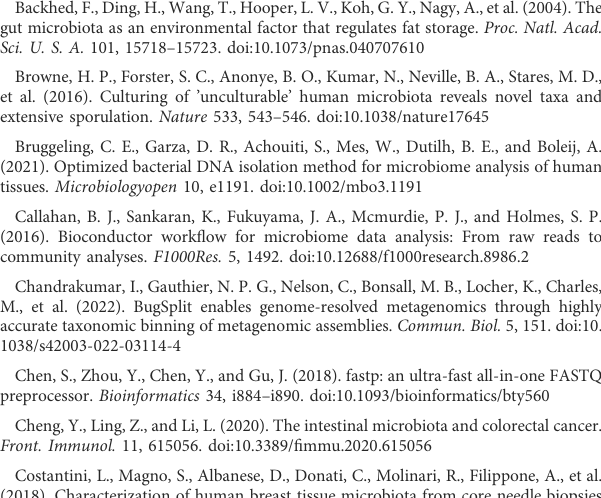
SUPPLEMENTARY FIGURE S1 Diversity differences based on host DNA abundance. The alpha and beta diversity differences were quanti fi ed using the Shannon index and the Aitchison distance, respectively, in relation to host DNA abundance. (A) The correlation between host DNA abundance and Shannon index was shown for all fi ve kits used in the study with the default setting (left panel), as well as for three kits with lab-optimized protocols (right panel). Each sample is represented by a dot, and statistical signi fi cance was observed in both panels (p-value < 0.05). (B) The differences in host DNA abundance with Aitchison distance, with the left panel displaying results for all fi ve kits used with the manufacturer ’ s instruction and the right panel showing results for three kits with lab-optimized